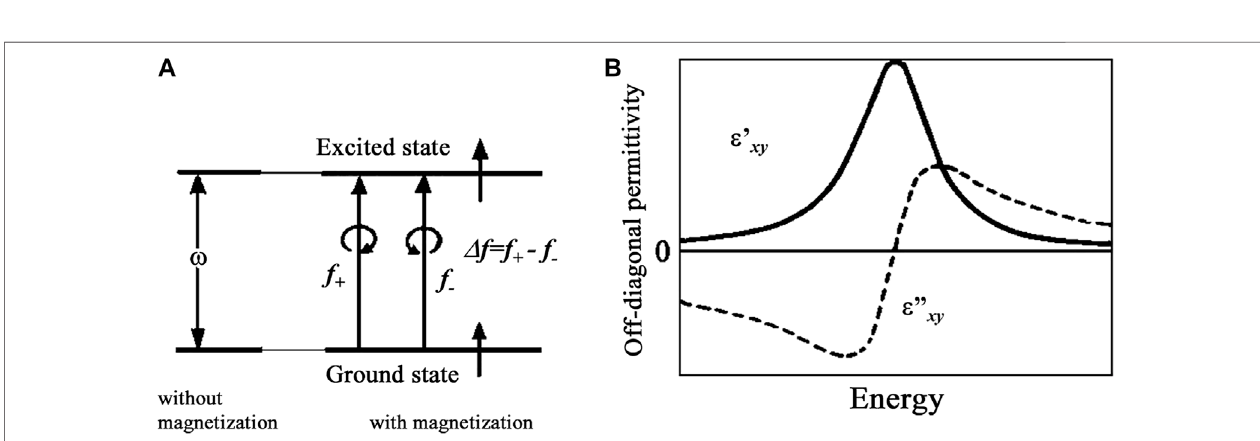
FIGURE 7 | Paramagnetic term of magneto-optical spectra (A) Energy level diagram without splitting and with a difference in oscillator strengths for RCP and LCP (B) Paramagnetic spectra of off-diagonal dielectric permittivity.